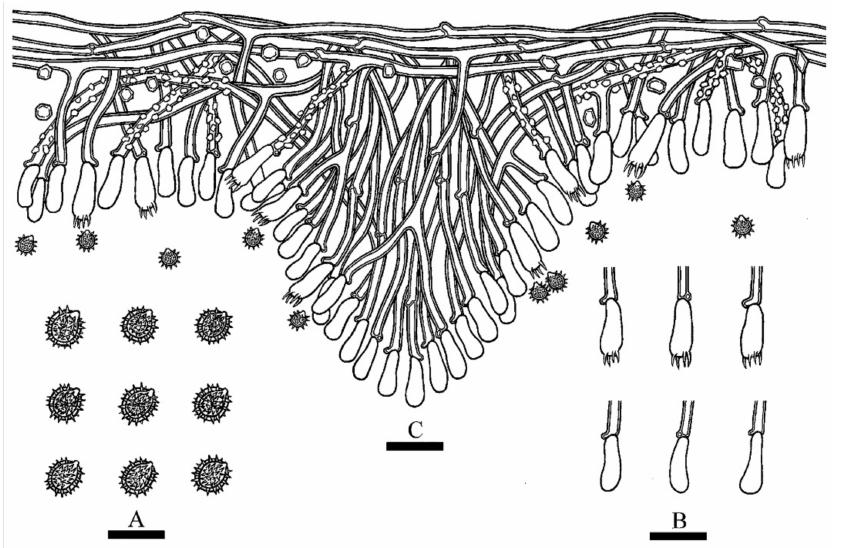
Figure 4. Microscopic structures of Trechispora murina (holotype CLZhao 11752): basidiospores ( A ), a cross-section of basidiomata ( B ), basidia and basidioles ( C ). Bars: ( A ) = 5 µ m, ( B , C ) = 10 µ